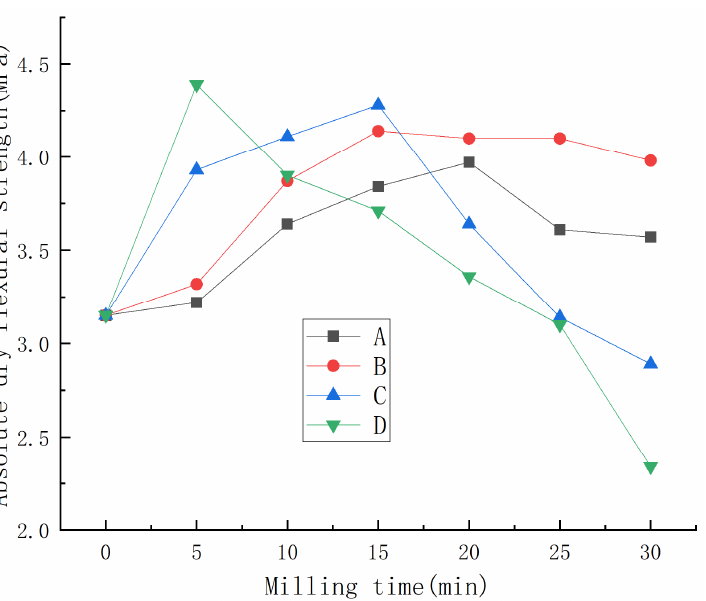
Figure 1. Effect of ball milling on absolute dry flexural strength of phosphorus building gypsum.